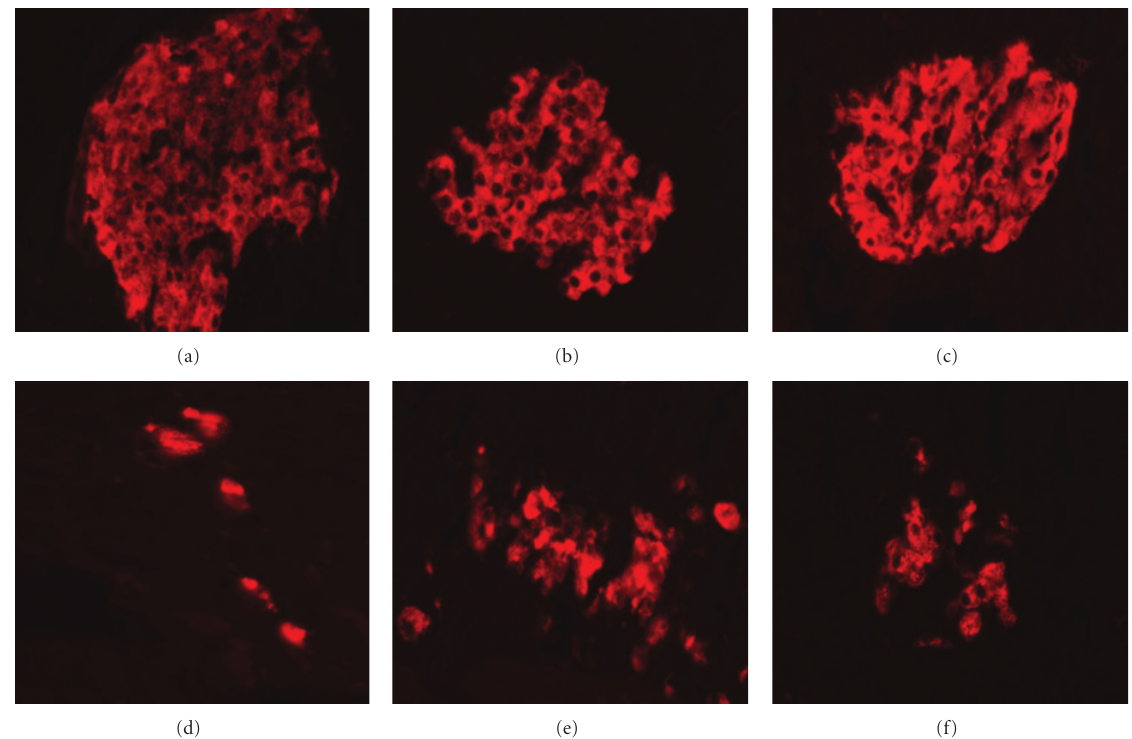
Figure 8: Immunodetection of insulin using rhodamine-conjugated secondary antibody in NF (a, d), IF (b, e), and CR (c, f) control (a, b, c) and STZ (d, e, f) rats.